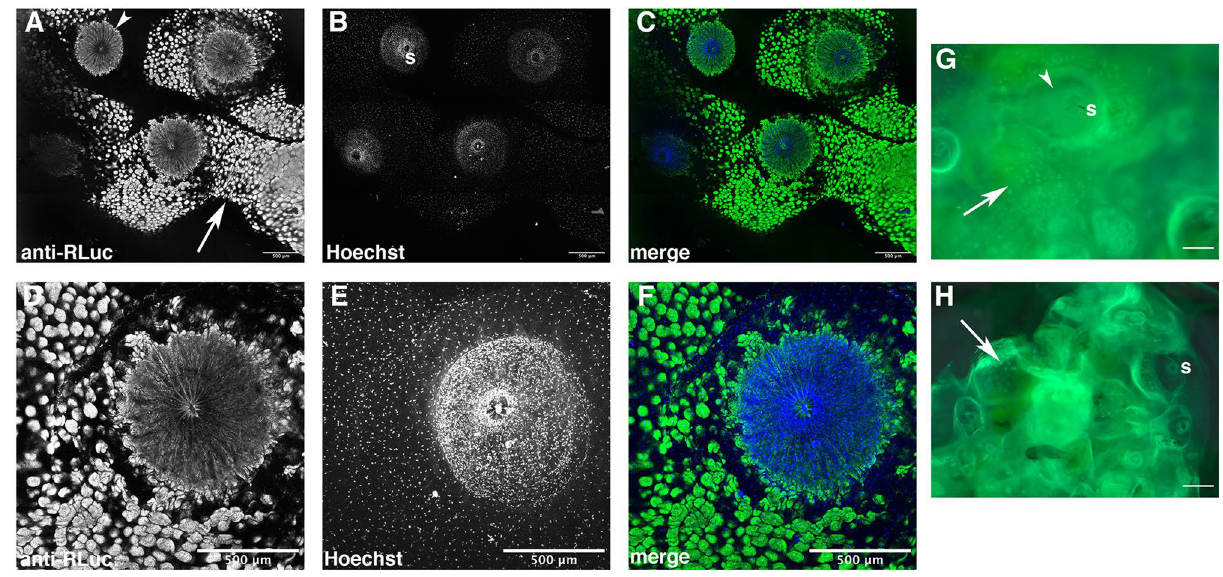
Figure 5. Expression of Renilla -like luciferase protein in Pyrosoma atlanticum . ( A – F ) Extended focus confocal projections of pyrosomes immunostained with an antibody to Renilla luciferase (anti-RLuc, green) and Hoechst (blue) to label nuclei. External views show incurrent siphons (s) of multiple ( A – C ) or single ( D – F ) zooids. Greyscale shown for A, B, D, and E; fluorescence shown for C and F. RLuc-like protein immunolocalizes to a large, circular structure underlying the incurrent siphon ( A , arrowhead). ( G – H ) Fluorescent stereomicroscope images of a sample incubated with RLuc antibody ( G ) or rabbit pre-immune serum as a control ( H ). Individual patches of staining outside the siphon (arrows) appear to be localized to the tunic, and were shown to be non- specific using pre-immune serum ( G , H and data not shown). Internal circular staining is specific to the RLuc antibody ( G , arrowhead). Scale bars, 500